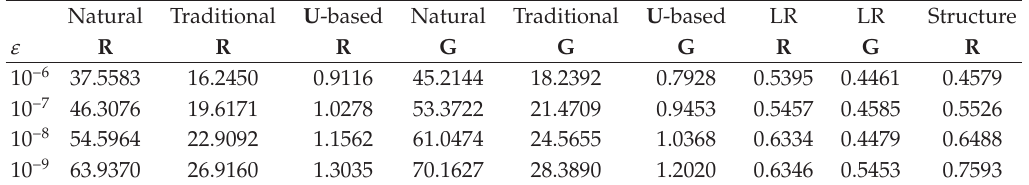
Table 6: Time in seconds required for di ff erent methods to execute for interarrival times having probability vector a (cid:7) (cid:5) 0 . 1 , 0 . 3 , 0 . 4 , 0 . 2 (cid:6)